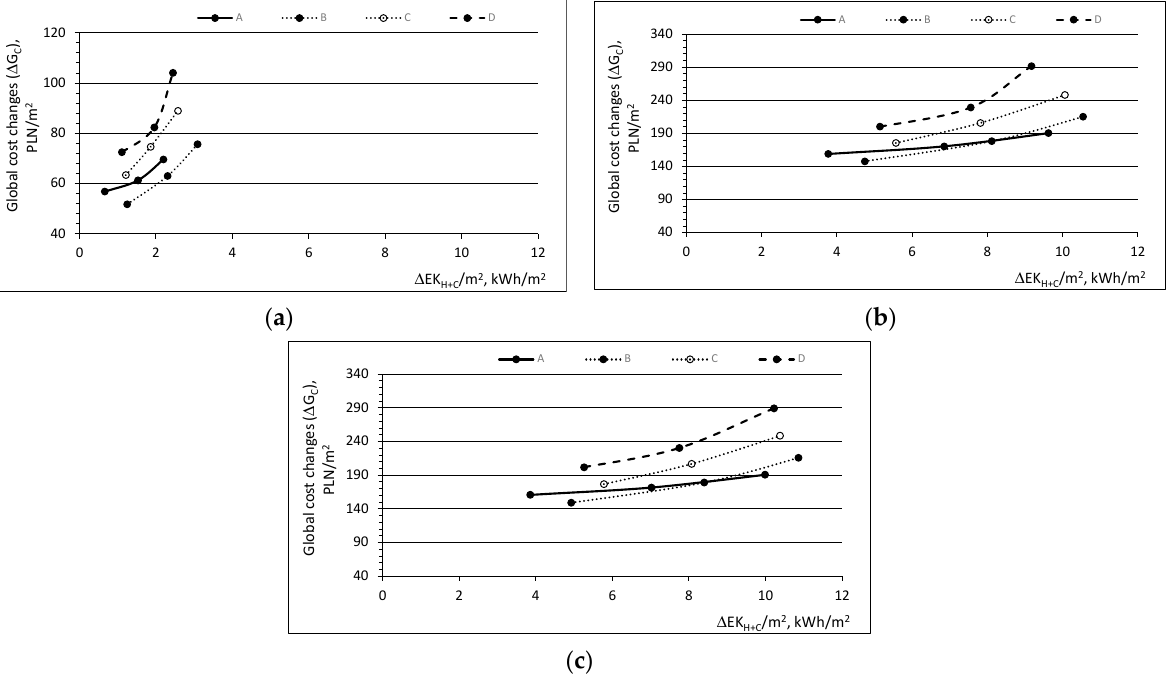
Figure 5. Increase of global cost in relation to the change of the value of final energy for the analyzed types and thicknesses of internal thermo-insulation for the Warsaw climatic zone and external insulation made of MW, ( a ) one external wall, ( b ) two external walls, ( c ) three external walls .